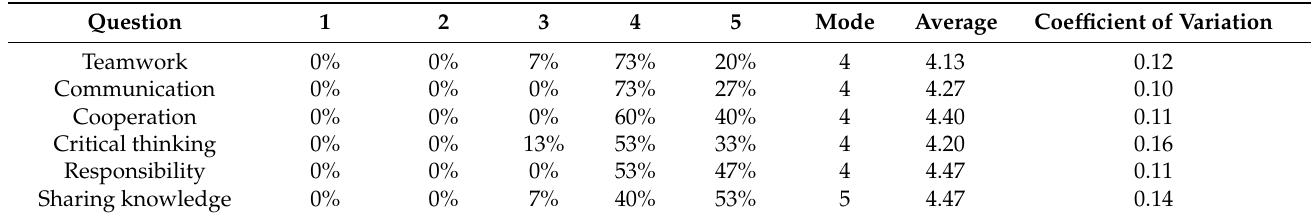
Table 5. Students’ perceived benefits from their integration into distributed